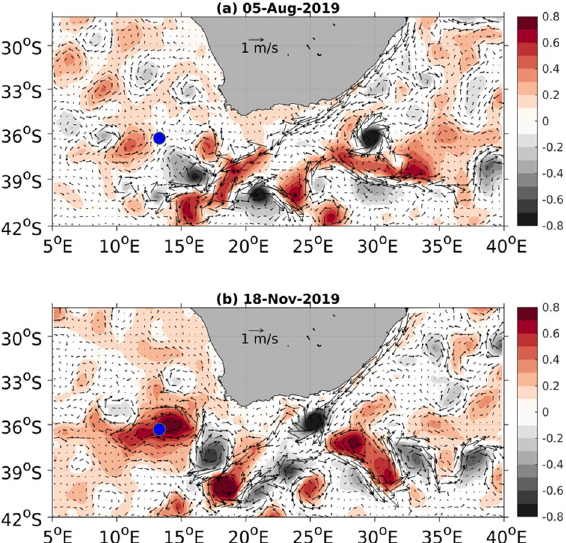
Figure 4. SLA anomalies (in m) between winter ( a ) and spring ( b ), 2019. The overlaying vectors represent the geostrophic currents (in m/s). The blue dot represents the GT10 station. (Data source: https:// cds. clima te. coper nicus. eu/ cdsapp# !/ datas et/ satel lite- sea- level- global? tab= form).